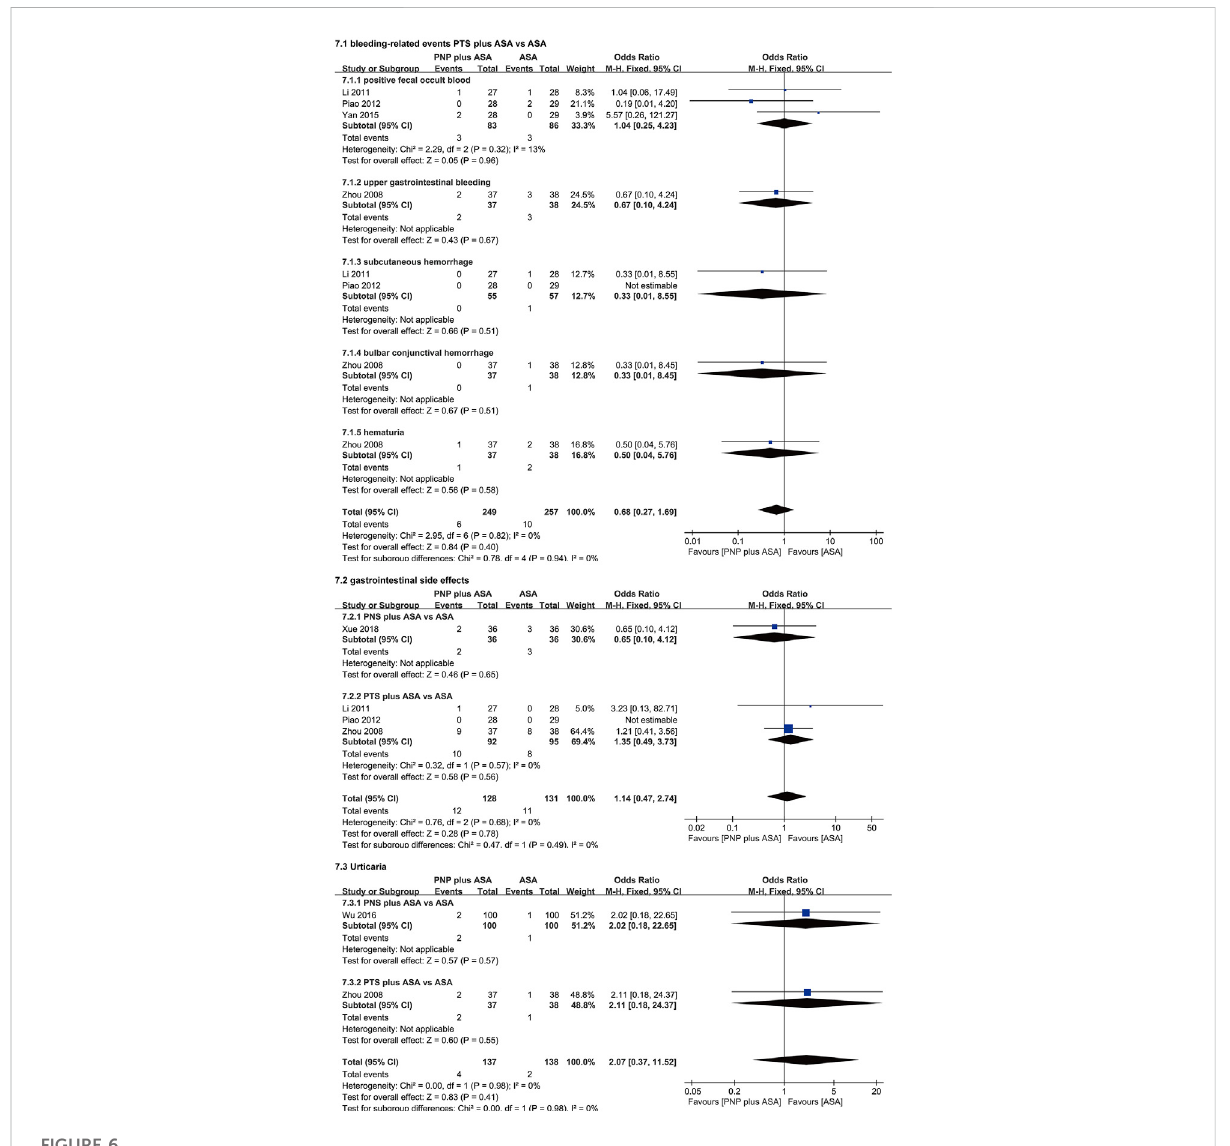
FIGURE 6 Forest plots of adverse